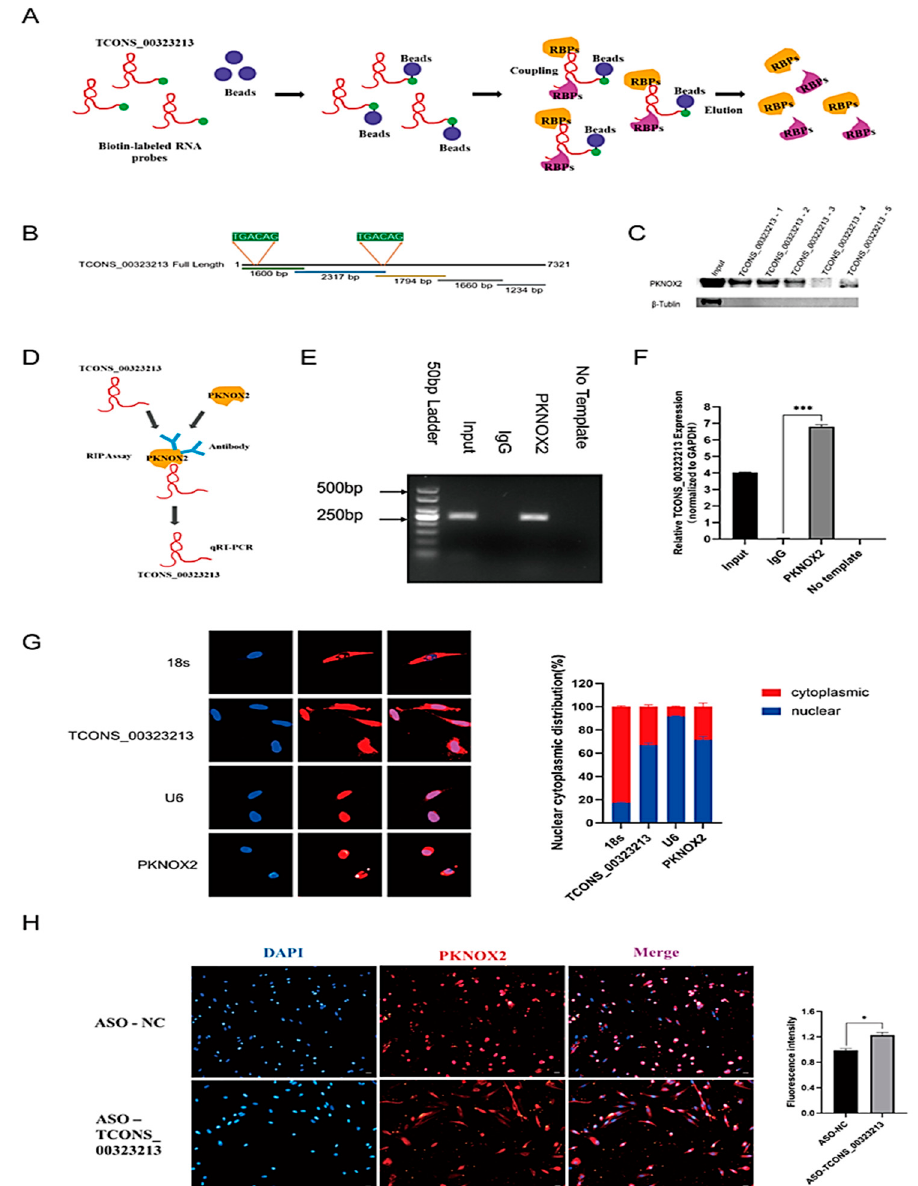
Figure 3. TCONS_00323213 physically interacts with PKNOX2. ( A ) A schematic representation of the RNA pull-down assays. ( B ) Location of the TCONS_00323213 -3 mutant fragments. ( C )